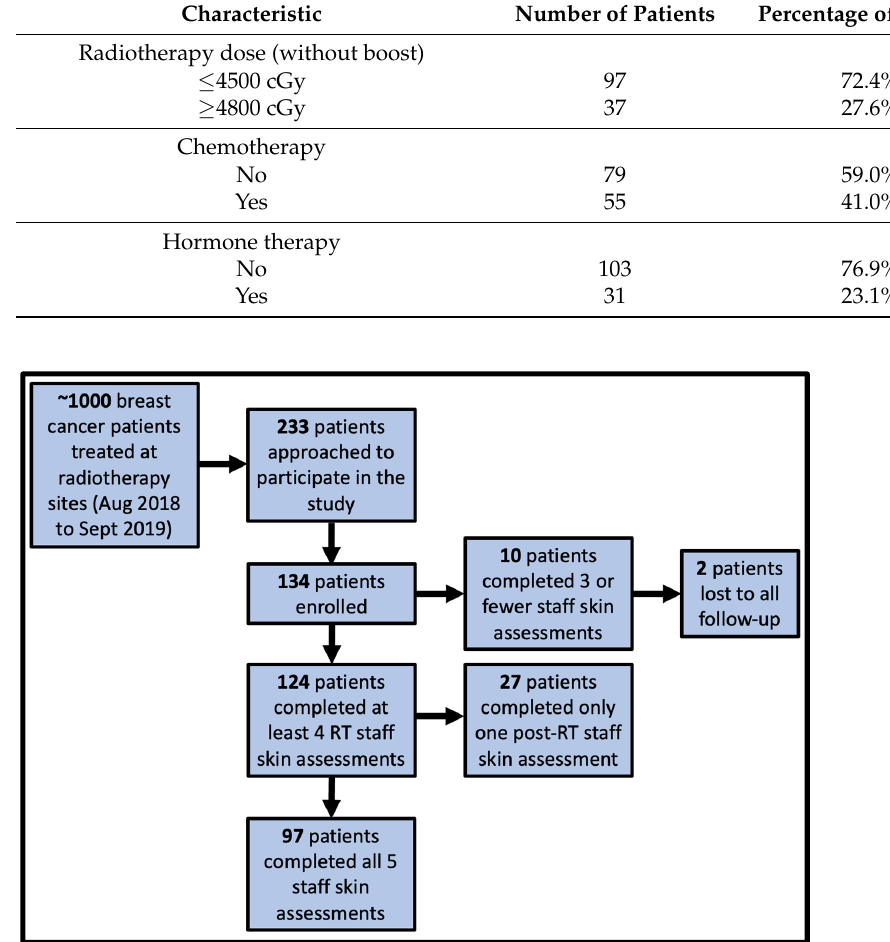
Figure 2. Number of participants who were approached, enrolled, returned to clinic for staff skin assessments, and lost to follow-up. There were three staff skin assessments during the course of radiotherapy (RT) and two post-RT staff skin assessments, resulting in a total of five staff skin assessments for each participant who completed the study.